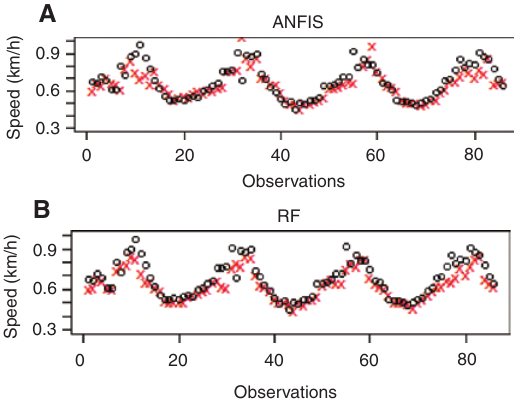
Figure 4: (A) Speed Prediction for the Next Hour using ANFIS. (B) RF at